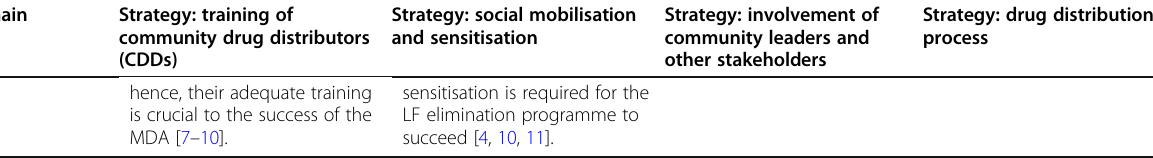
Table 1 Description of components of the context-specific evidence-based quality improvement intervention (Continued)